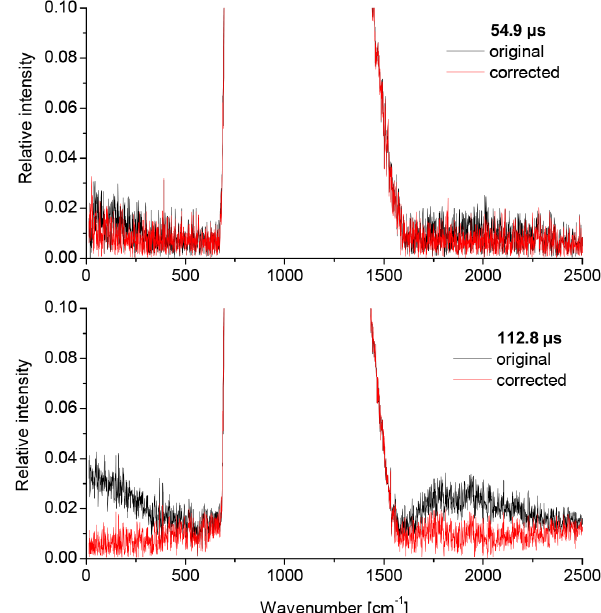
Figure 4. Blackbody spectra of pixel [24,68] measured during the flight on 13 September 2012 before (black) and after nonlinearity correction (red) for two different integration times: 54.9µs in the upper panel and 112.8µs in the lower panel. The blackbody temper- ature is 247K. The maximum of each spectrum is scaled to 1. The reduction of the quadratic artefact can be seen in both cases showing that the nonlinearity characterisation curve determined from labora- tory measurements can be applied to in-flight